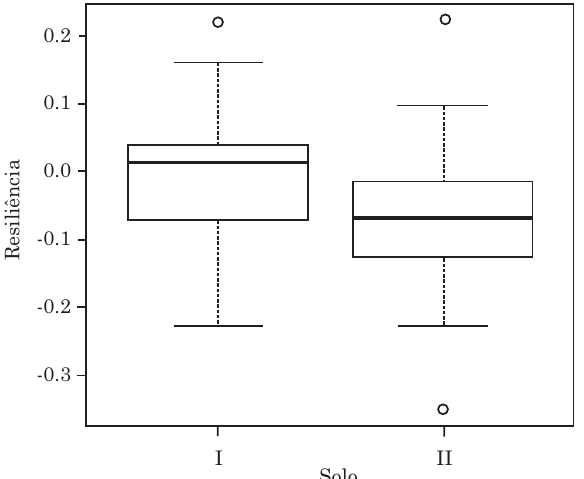
Figura 2. Distribuição dos índices de resiliência da densidade de dois Latossolos Vermelhos distróficos, um argiloso (I) e um franco-argilo- arenoso (II). As barras representam o intervalo de confiança da média (85 %).